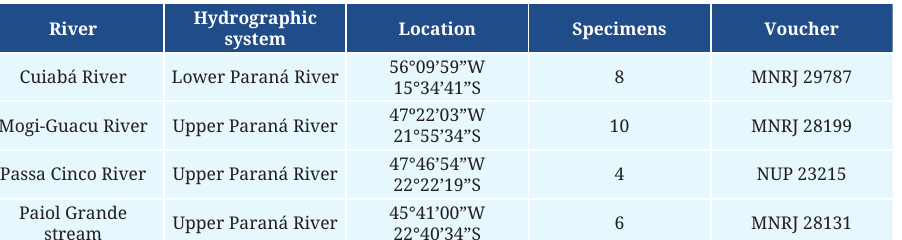
TABLE 1 | Collection sites of specimens of Parodon nasus , number of individuals analyzed and voucher